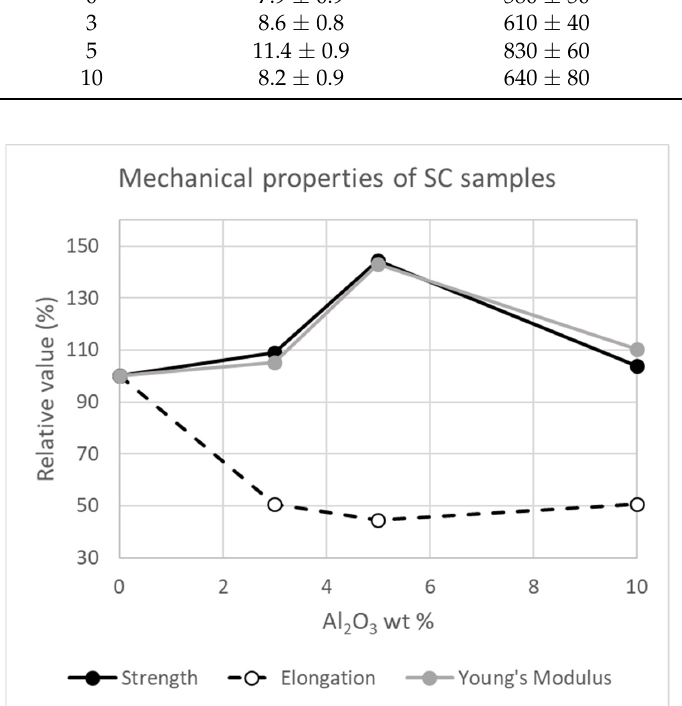
Table 1. Elastic modulus, elongation at break, and tensile strength of the solvent cast samples as measured by tensile tests.